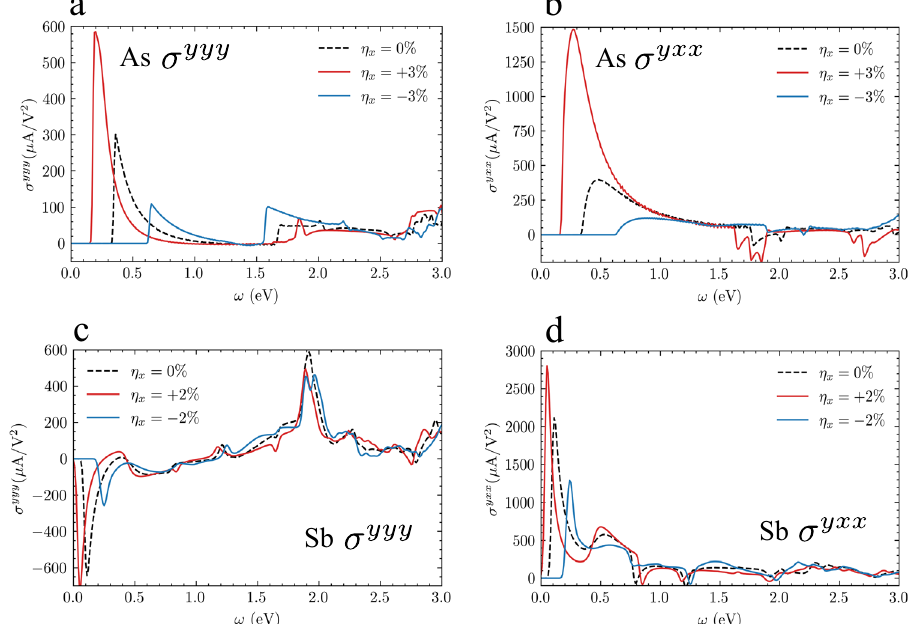
Fig. 10 Uniaxial strain tuning of shift current. Uniaxial strain dependence of a , c σ yyy and b , d σ yxx of monolayer As and Sb.